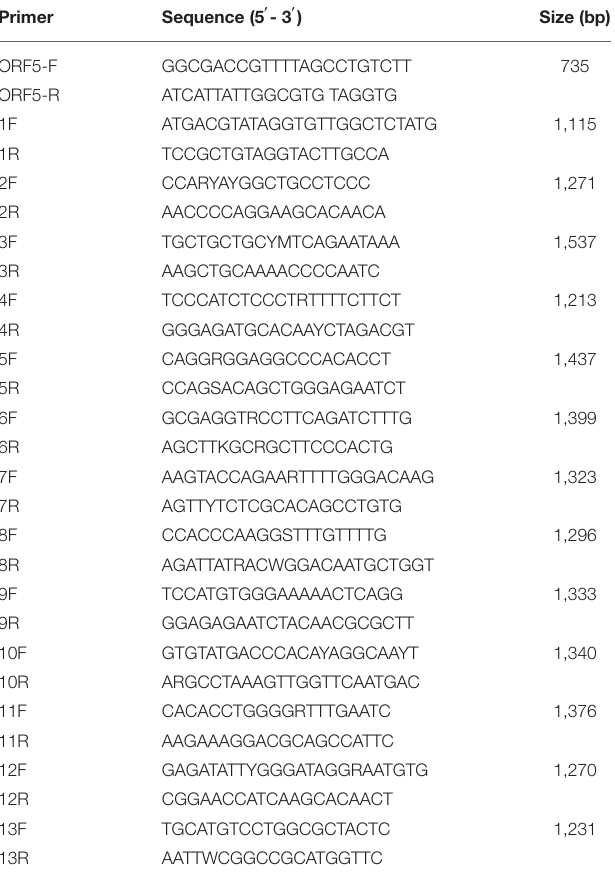
TABLE 2 | Information of 11 PRRSV isolates from South China in this study. Strain Area Time Accession no.